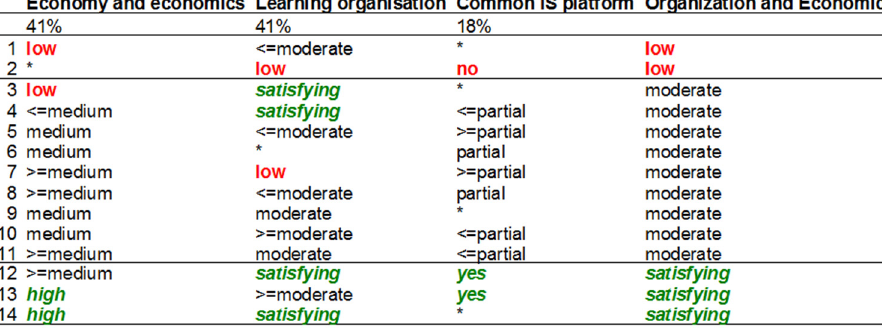
Figure A2. Utility function of the aggregated attribute Organization and Economics.